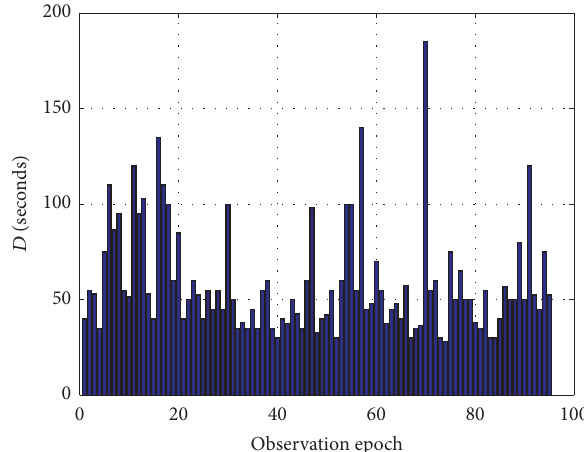
Figure 8: Back-to-back duration using period 2 observation data.